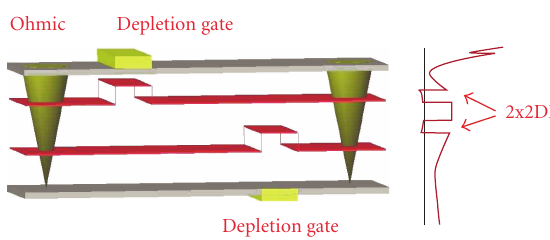
Figure 1: A schematic representation for independent ohmic contacts to a 2x2DEG. A similar method will work for a 2x2DHG as well. Notice that the 2DEG exists due to carriers from ionised dopants before the contacts are made. The sketch on the right hand side shows the rough profile of the bottom of the conduction